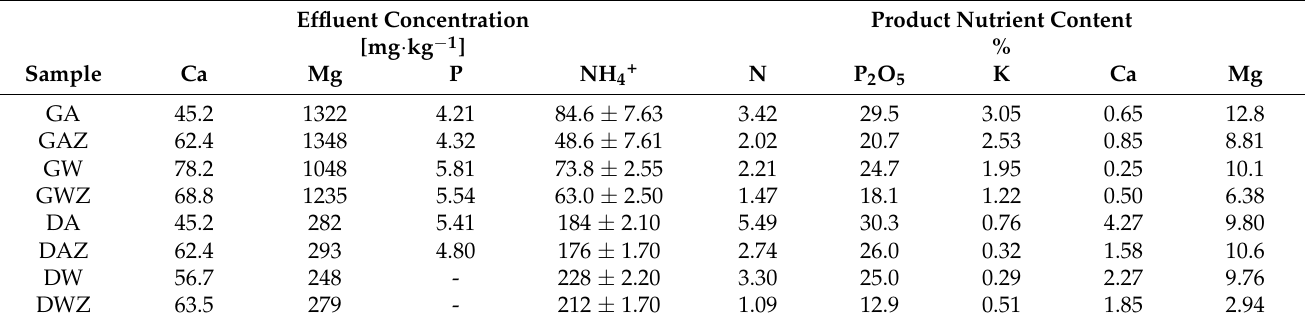
Table 3. P and other element concentrations in effluent, and the content of nutrients in the struvite-zeolite fertilizer. Effluent Concentration Product Nutrient Content [mg · kg − 1 ] %